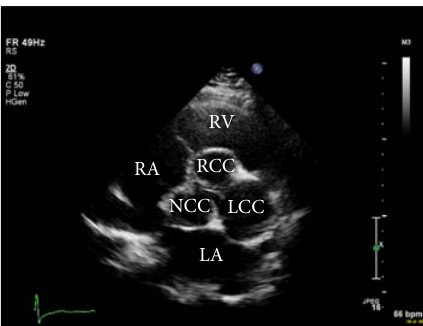
Figure1:Parasternalshortaxisviewoftheaorticvalveshowsdilated left sinus of Valsalva. Note that the left coronary cusp (LCC) is markedly enlarged compared to the other two cusps. Normally, all three cusps are equal in size. RV: right ventricle, RA: right atrium, and LA: left atrium. RCC: right coronary cusp; NCC: noncoronary cusp.